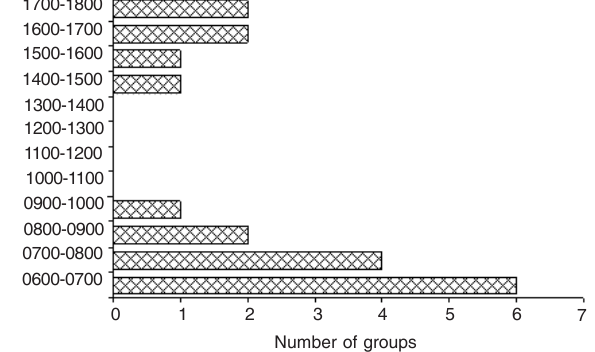
Figure 2. Temporal sighting periods of Hoolock hoolock at Namdapha National